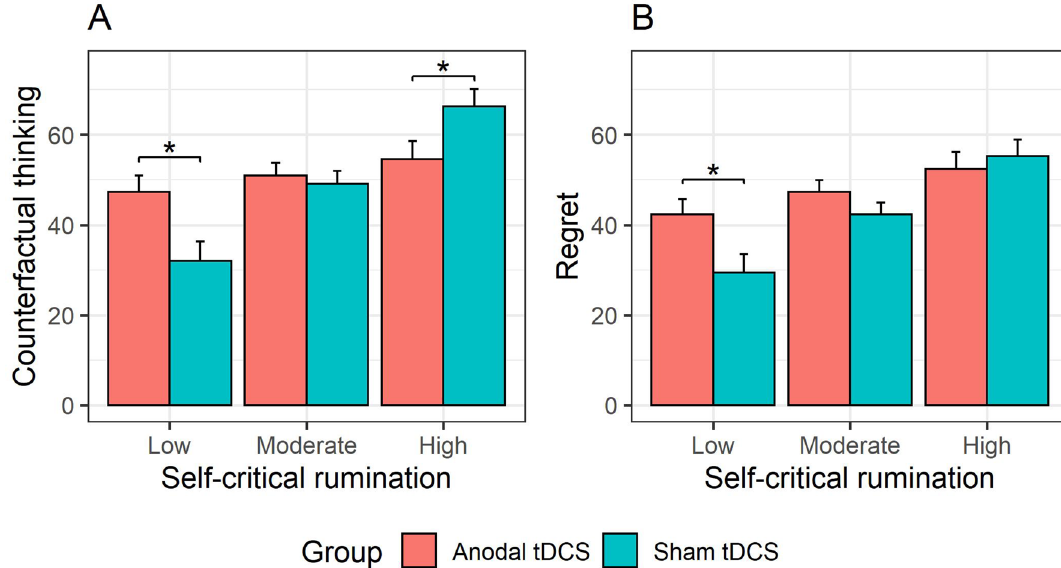
Figure 3. Role of level of self-critical rumination in tDCS effects on counterfactual thinking ( A ) and regret ( B ). Error bars reflect the standard error. * p < 0.05.